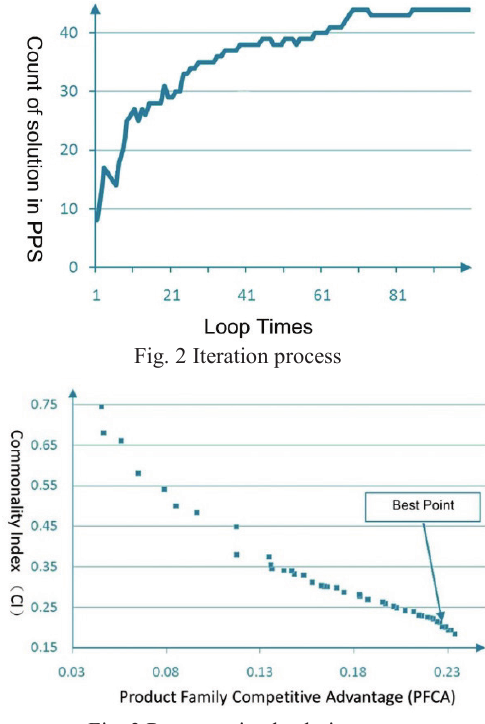
Fig. 3 Pareto optimal solution